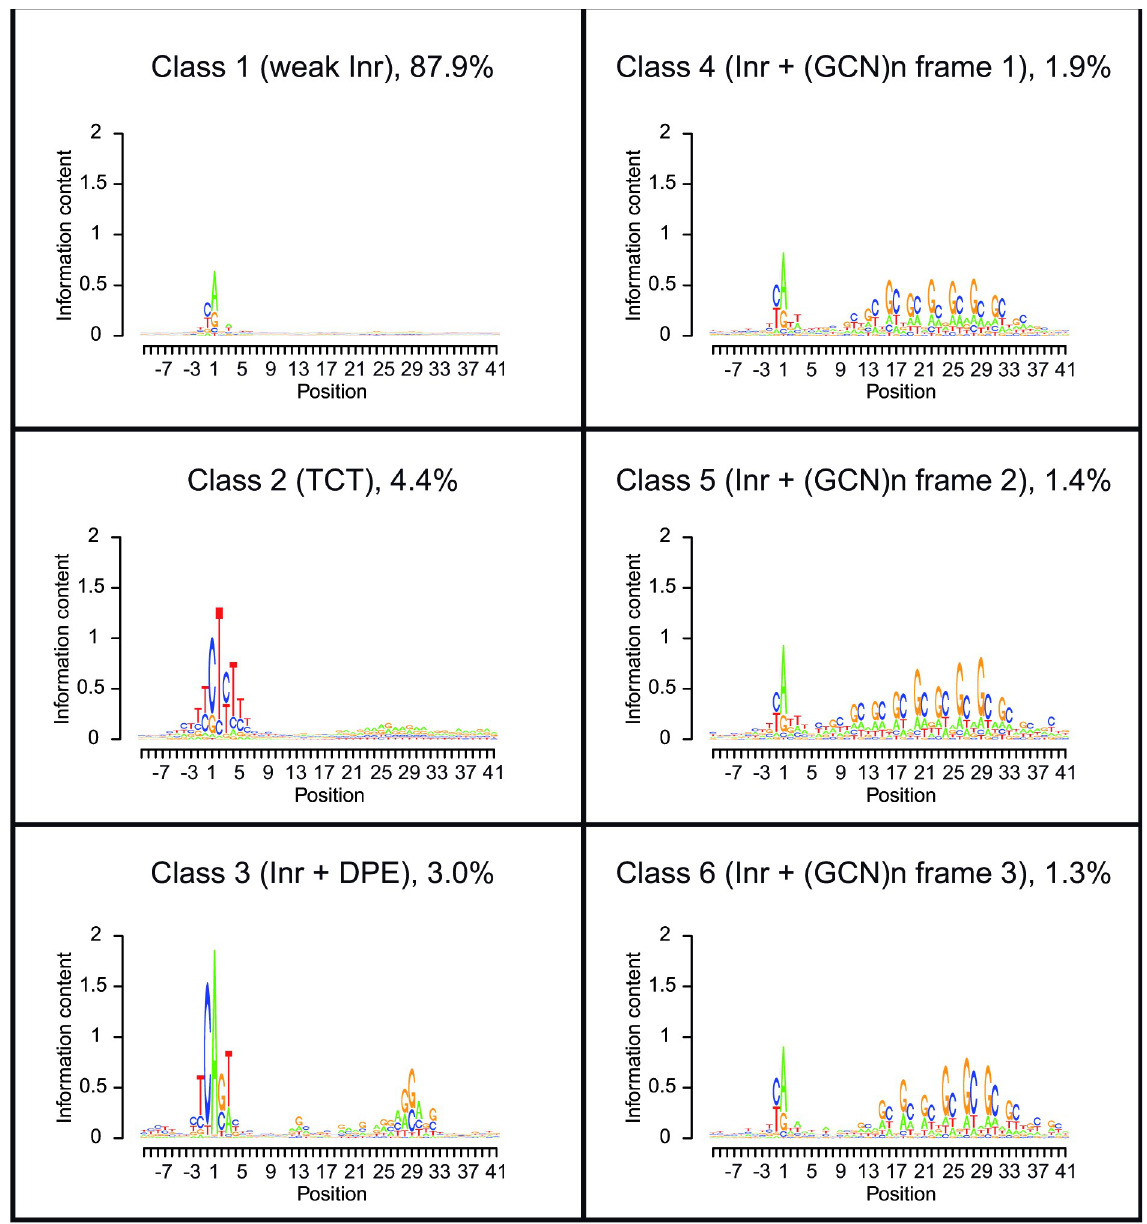
Fig 3. Partitioning of human promoter sequences using the newly developed extended EM algorithm. Six most frequent classes were identified within human promoters. The third most frequent class, which very much resembles the Inr+DPE class found in Drosophila , accounts for 3% of human core promoters. For each class, its frequency among the examined promoters is indicated. Numerical data are provided in S2